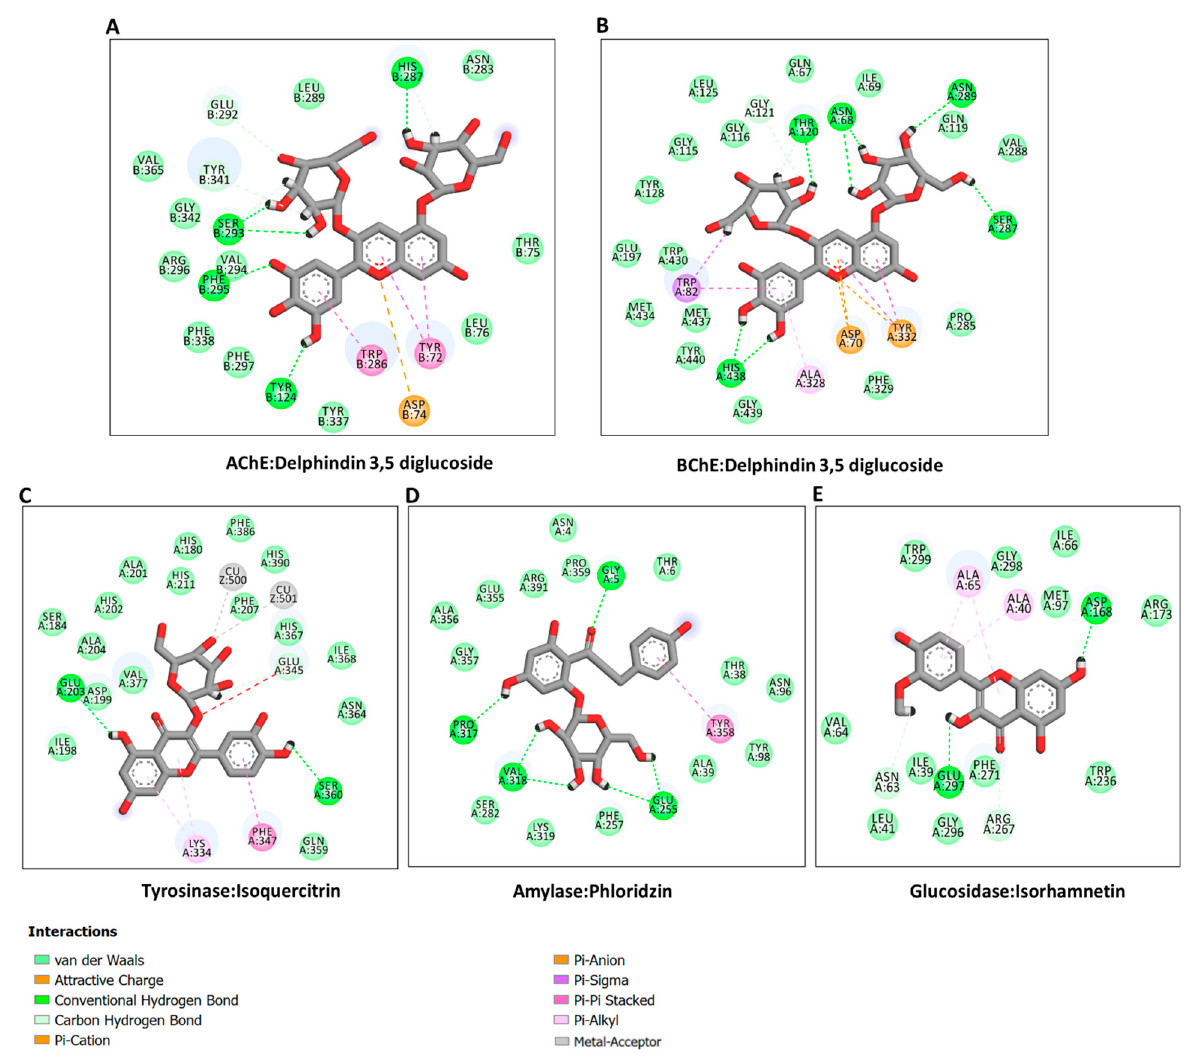
Figure 4. Protein–ligand interactions: ( A ) ChE:delphindin 3,5 diglucoside; ( B ) BChE:delphindin 3,5 diglucoside; ( C ) tyrosinase: isoquercitrin; ( D ) amylase: phloridzin; and ( E ) glucosidase:isorham- netin.